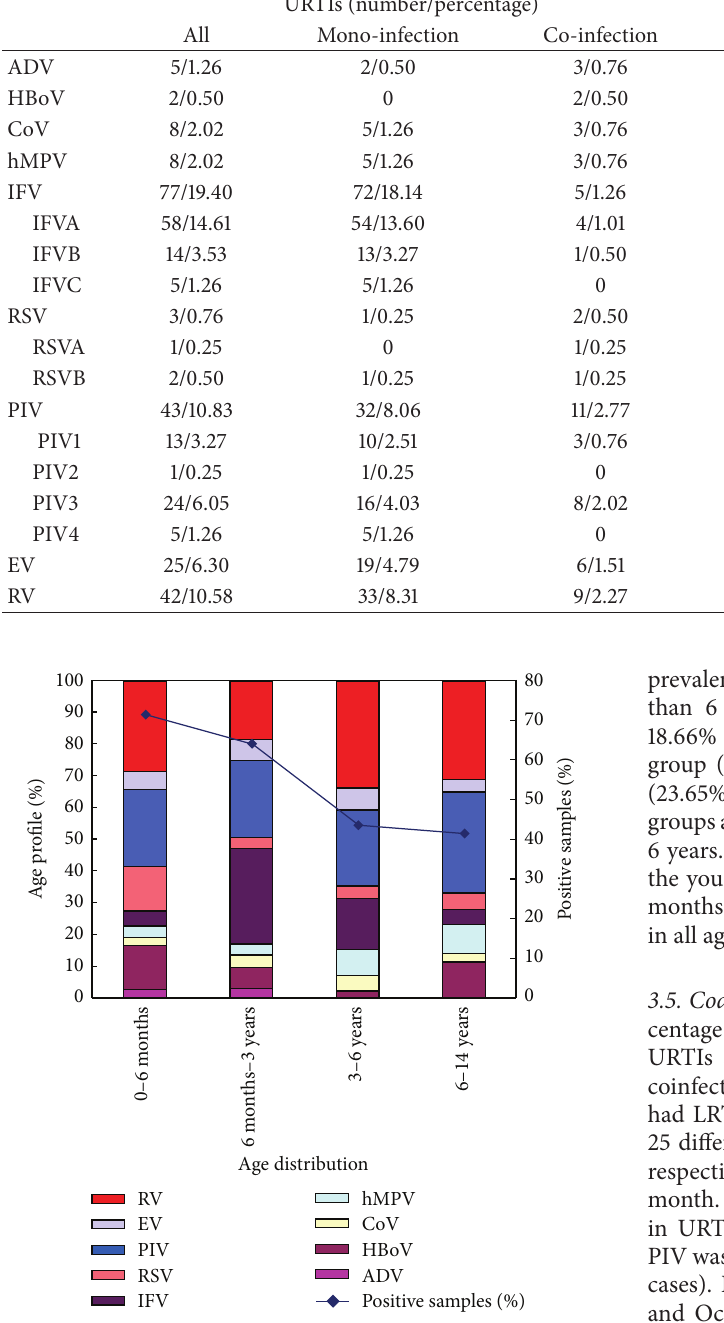
Figure 4: Percentage of samples that was positive for various viruses in different age groups of